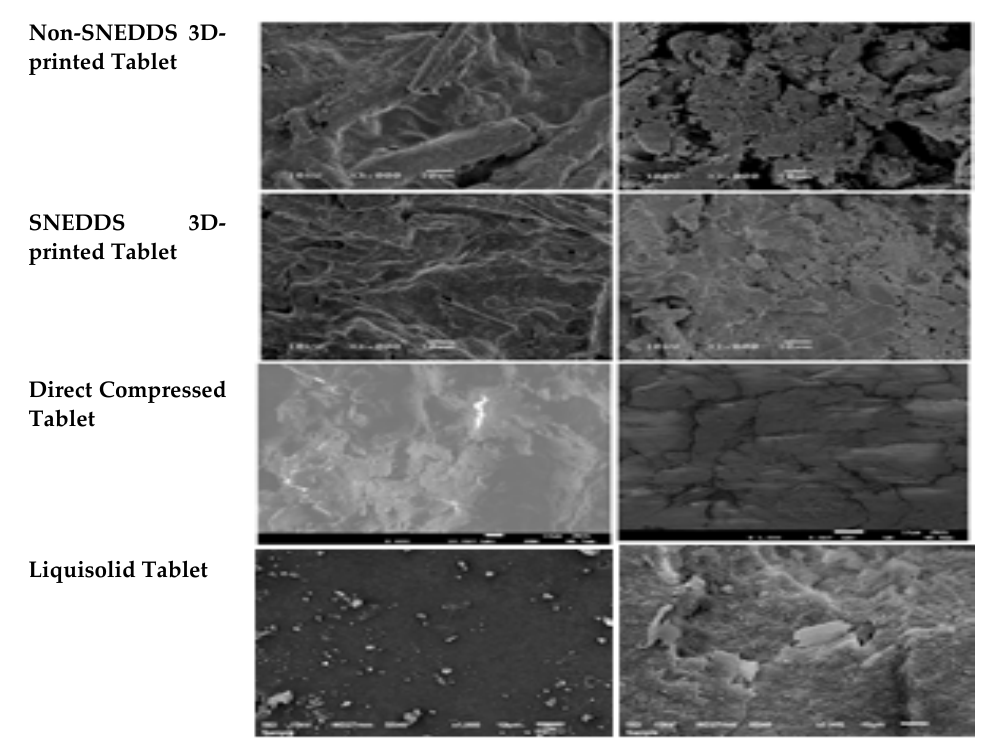
Figure 3. SEM images for the surface and inner structure of the prepared tablets.